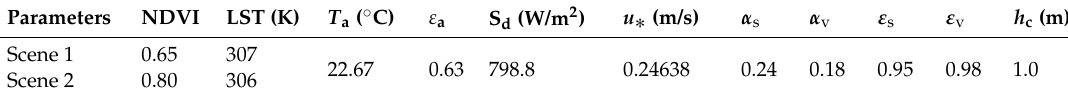
Table 1. Parameters of the initial scenes for sensitivity analysis.